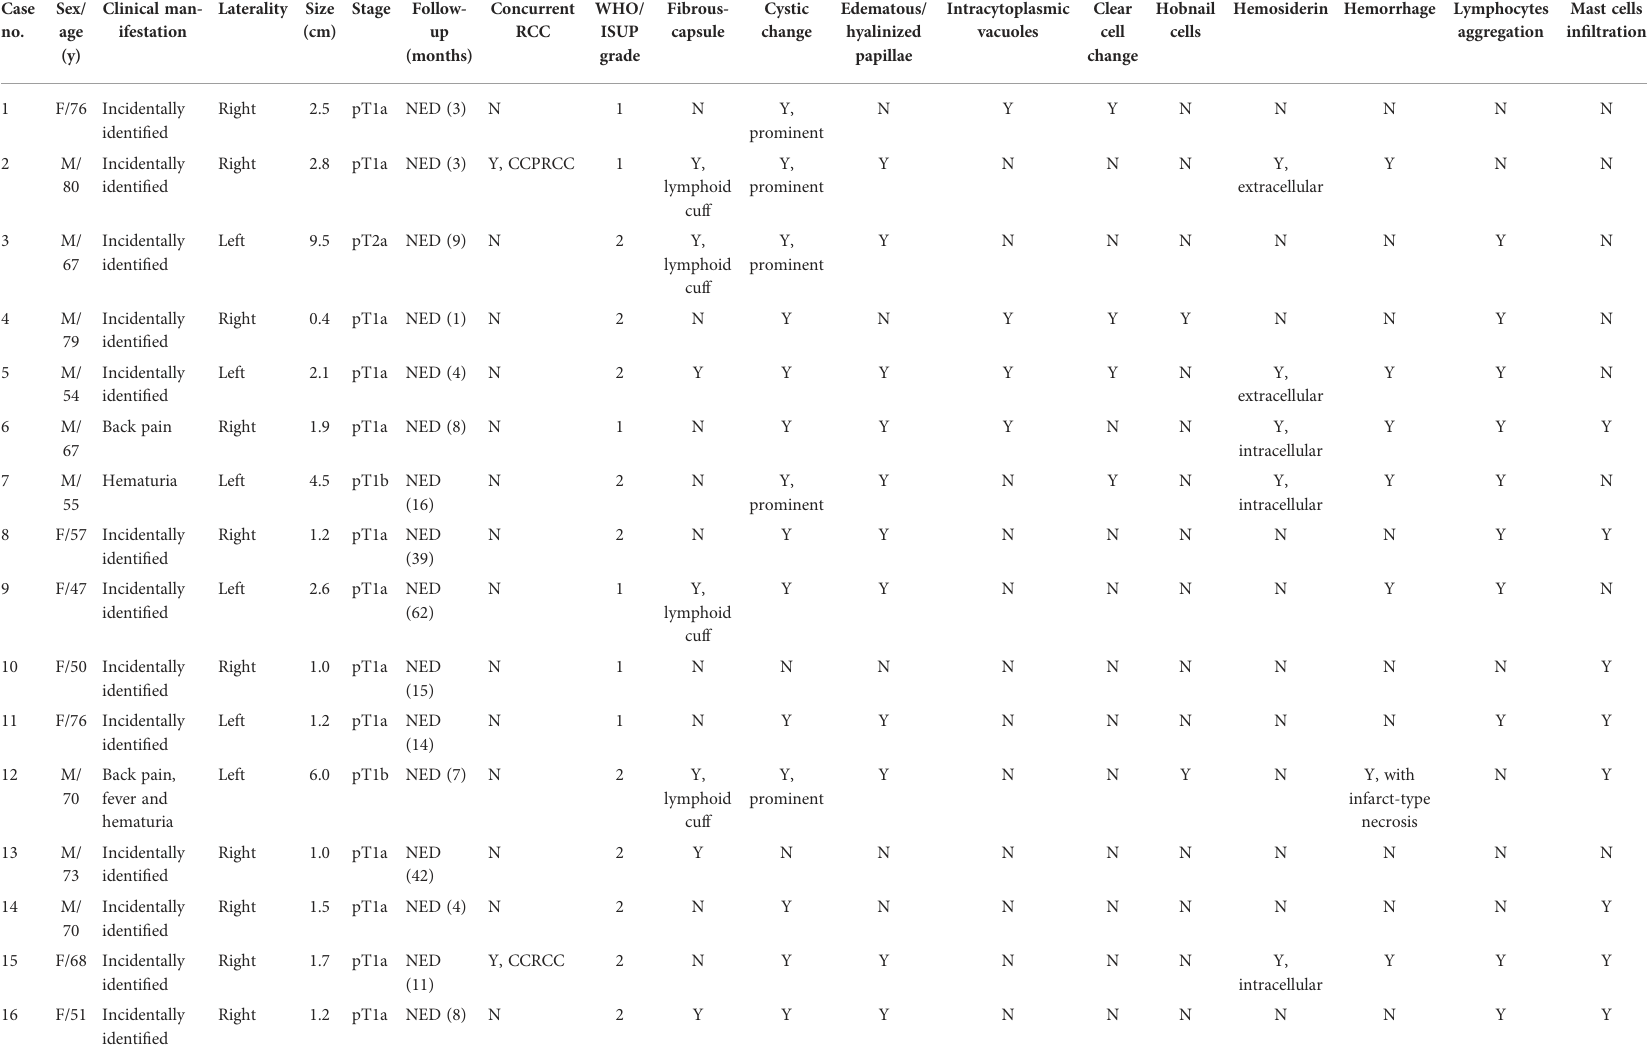
TABLE 1 Clinicopathological characteristics of PRNRP. Case